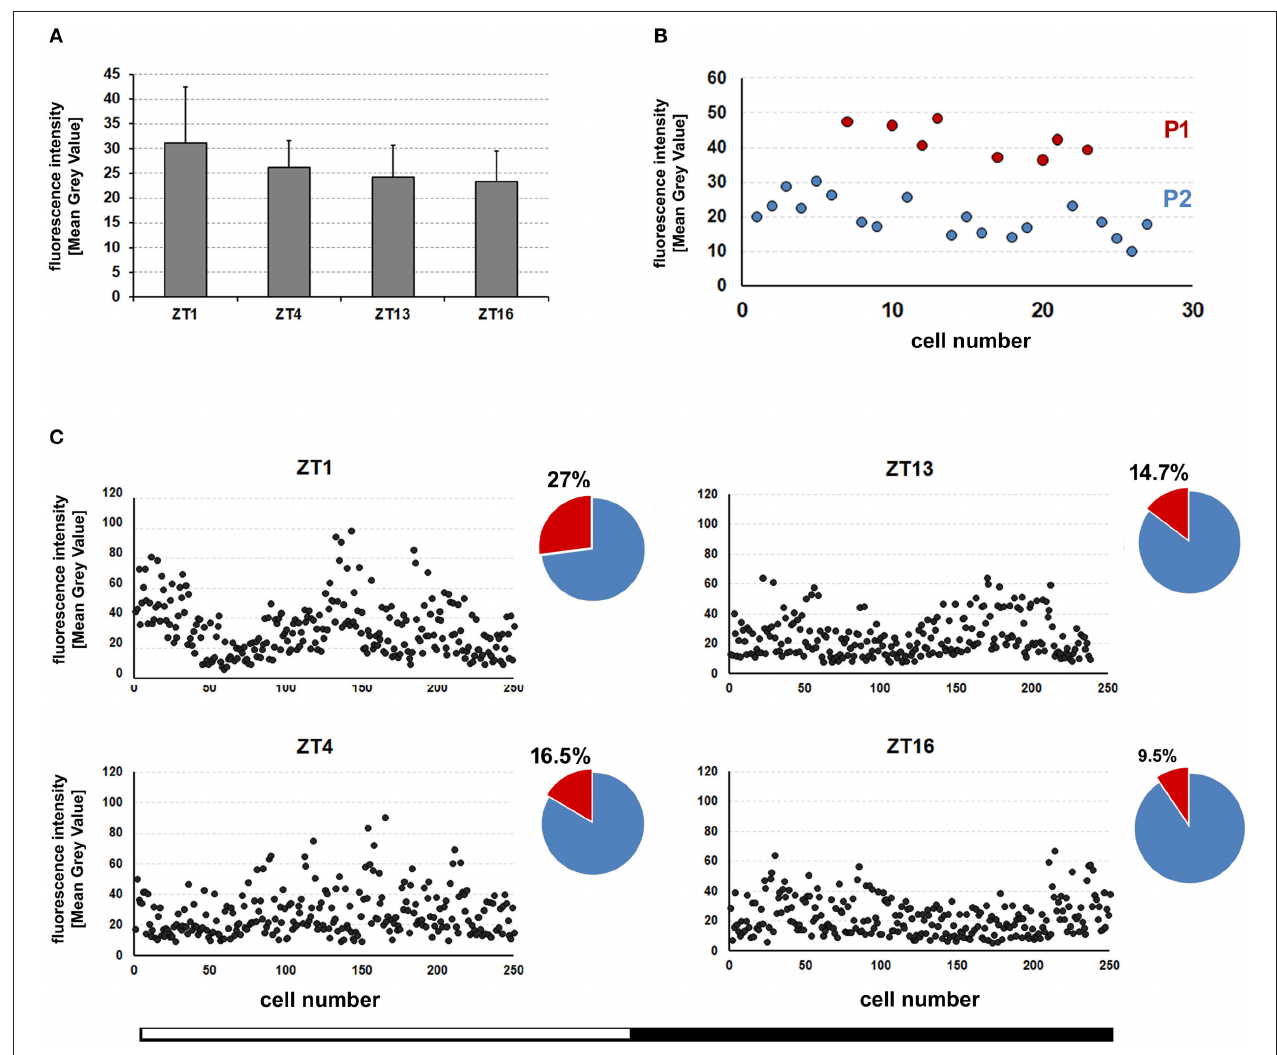
FIGURE 3 | (A) The average ( ± SD ) level of REPO-specific fluorescence in the nuclei of the dMnGl of CS flies collected at different times (ZT1, ZT4, ZT13, and ZT16) of the day. For each time point the fluorescence was measured in the dMnGl of 10 hemispheres ( N = 10). (B) The consecutive measurements of REPO fluorescence in the dMnGl ( N = 27) of an exemplary optic lobe, revealing distinct populations of cells with higher (P1) and lower (P2) levels of fluorescence at ZT1. (C) The measurements of REPO fluorescence in the dMnGl of flies collected at designated ZTs. Each chart shows measurements for 250 nuclei from 10 optic lobes. The accompanying pie charts illustrate percentages of nuclei with the intensity of fluorescence below (blue) and above (red) the MGV of 40.